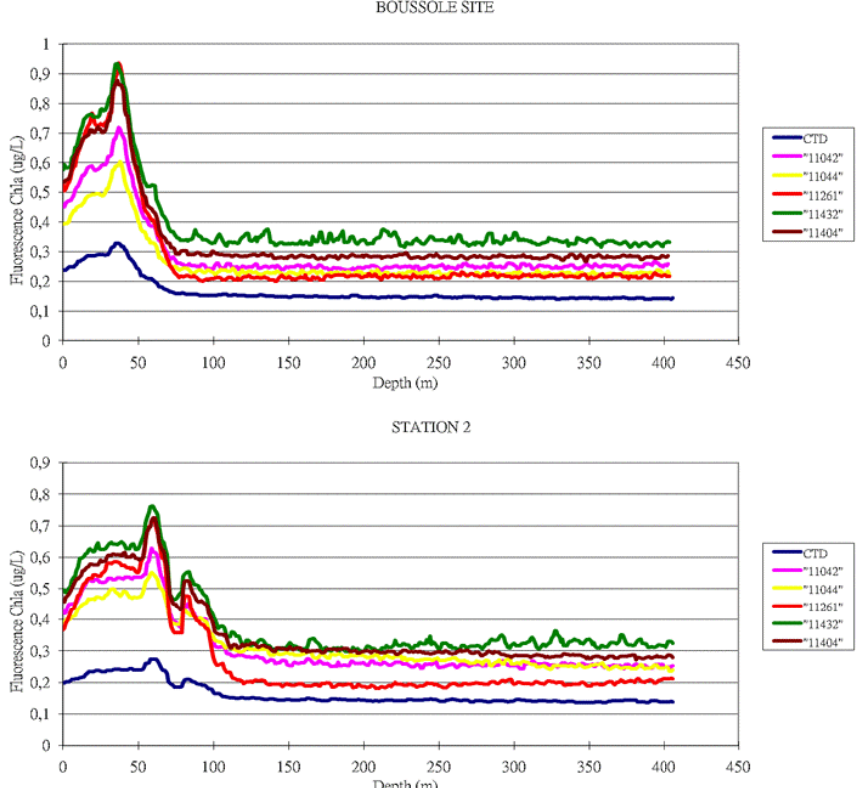
Figure 2. Example of fluorescence profiles provided by di ff erent CTD-FLUO-SRDLs and the reference fluorometer (in blue) obtained at two di ff erent stations. These profiles exhibit the existence of a fluorescence o ff set di ff ering between CTD-FLUO-SRDLs. Fluorometers were providing consistent data between each other, but di ff ered in the absolute amount of fluorescence